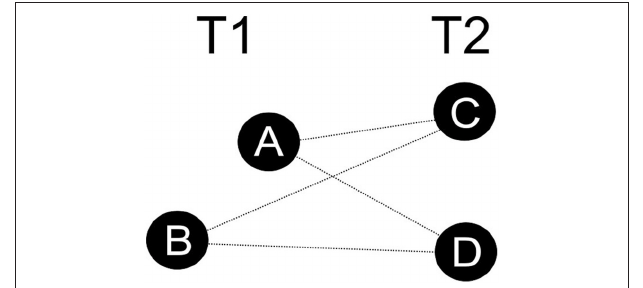
FIGURE 1 | A splitting-like